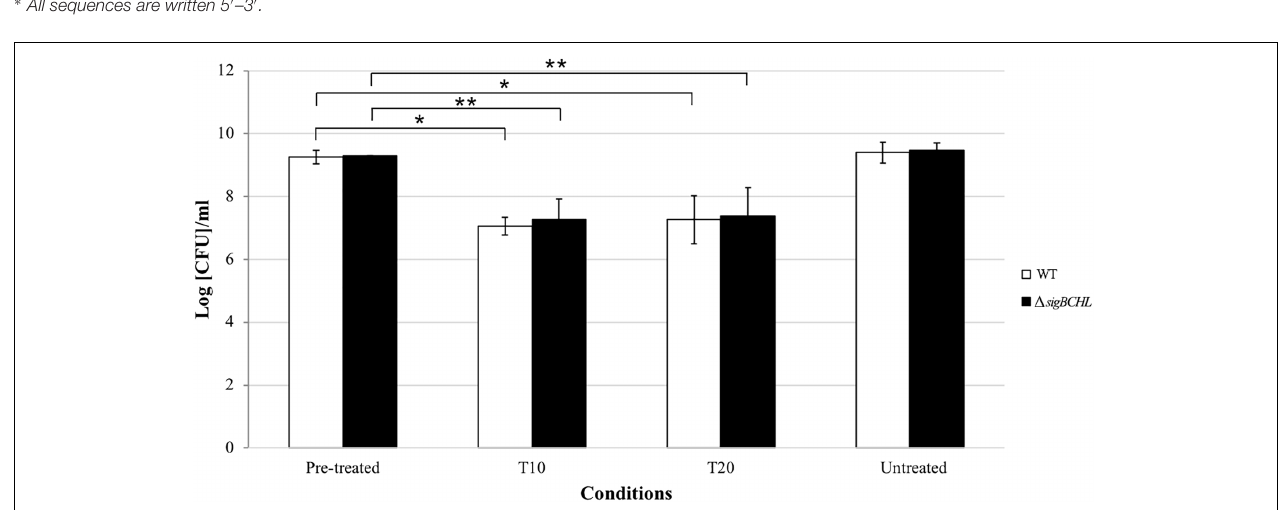
FIGURE 1 | Survival of Listeria monocytogenes 10403S wild type and its quadruple mutant in simulated gallbladder bile at various time points: pre-treated control, T10, T20, untreated control; WT (white), (cid:49) sigBCHL (black). Asterisks indicate significant difference when compared to pre-treated controls using t -test ( p < 0.05).